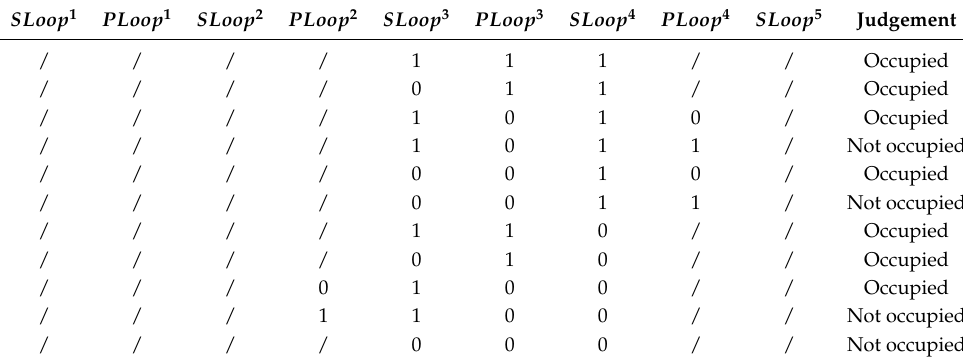
Table 4. Judgement of whether Lane 3 is occupied.